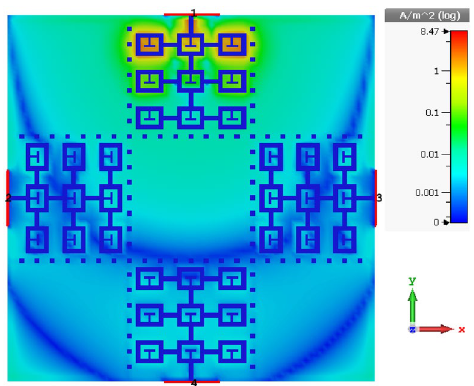
Figure 6. Current density over the proposed antenna array at 4.25 GHz.